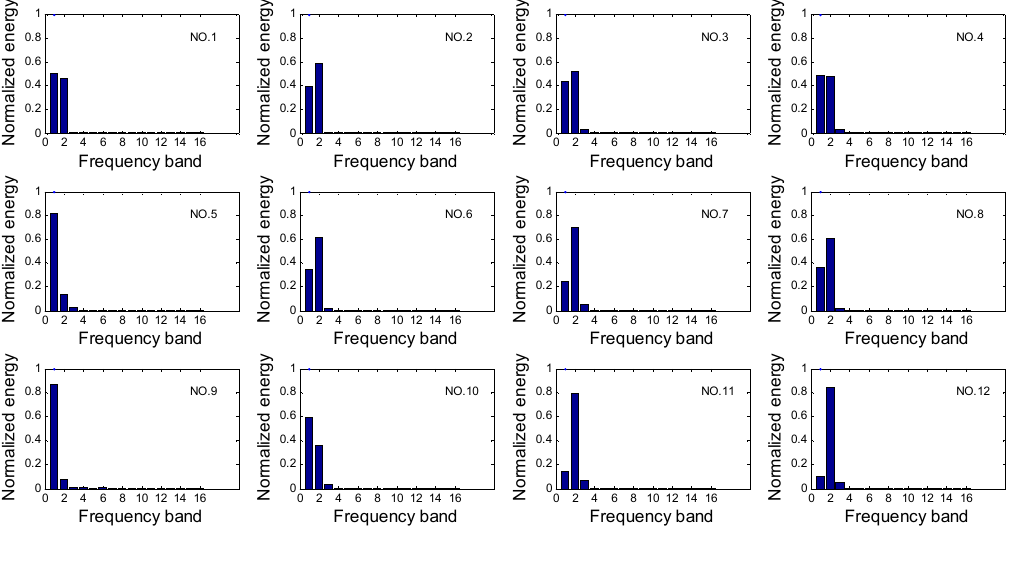
Figure 6. Wavelet packet energy spectrum of one set of echo